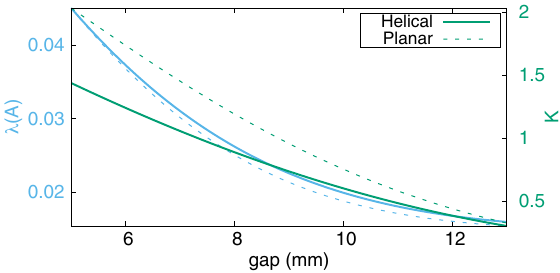
FIG. 8. Radiation wavelength (left axis, blue) and K value (right axis, green) for a 40 GeVelectron beam passing through the Delta undulator as a function of the undulator gap, in case of helical (solid lines) or planar mode of operation (dashed lines). The period length of the undulator is taken to be 18 mm.